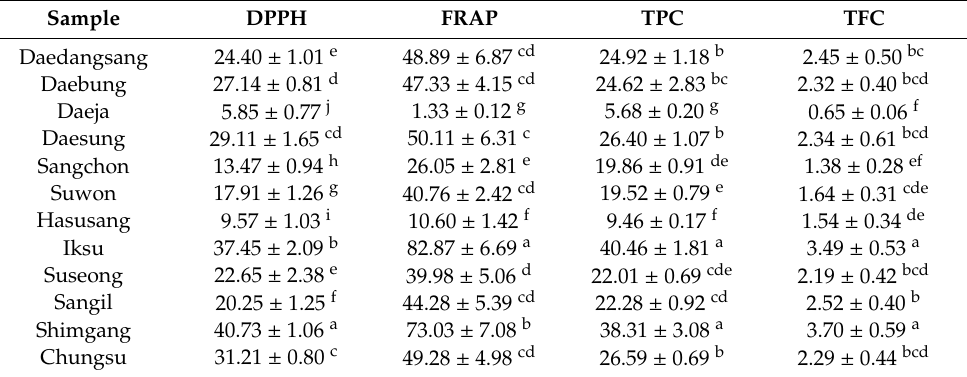
Table 2. Total phenolic content, total flavonoid content, and antioxidant activities of 12 mulberry